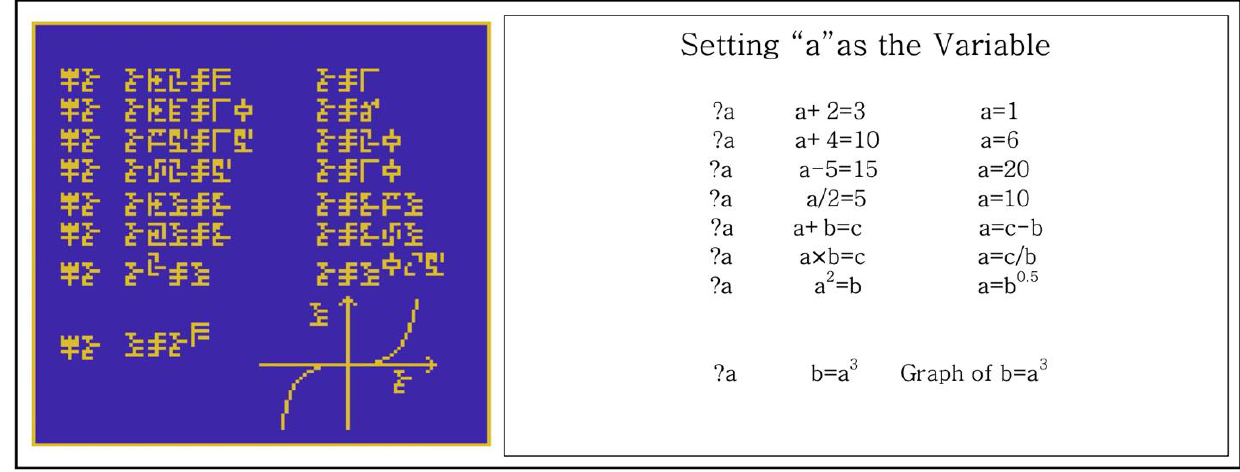
Figure 10. Pictural representation and explanation of algebra in the Message, page 4.